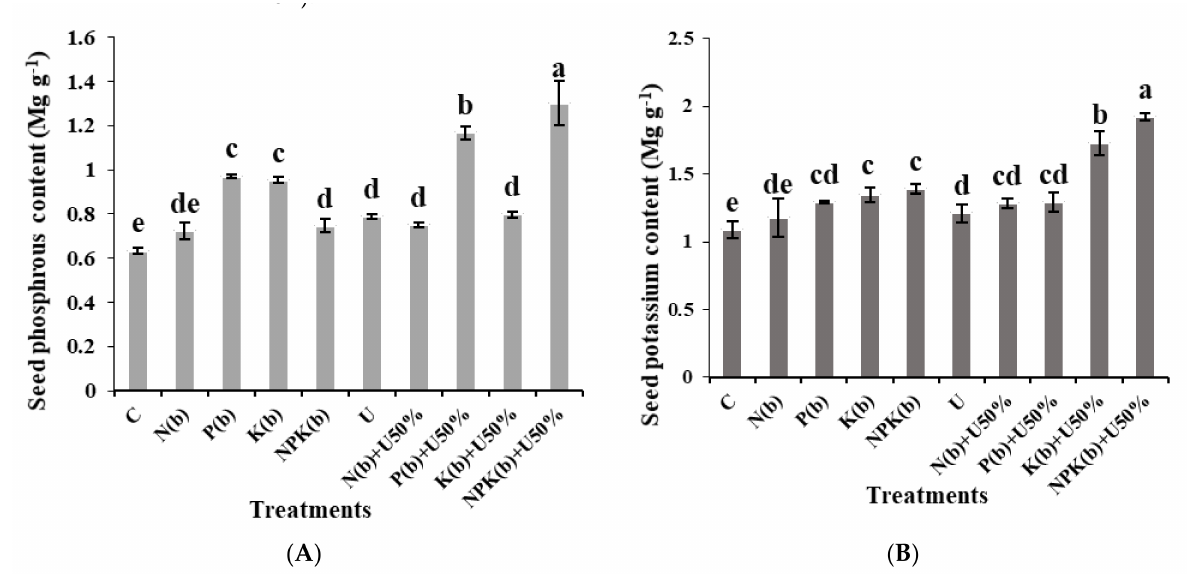
Figure 8. Means comparison for seed phosphorous content ( A ) and seed potassium content ( B ) of Nigella sativa L. as influenced by biofertilizers and chemical urea. Different letters indicate a significant difference according to PLSD test with 3 replications at the p ≤ 0.05 (chemical urea fertilizer (U), biofertilizer N (b) , biofertilizer P (b) , biofertilizer K (b) , mixed biofertilizer NPK (b) , 50% urea + biofertilizer N (N (b) + U 50% ), 50% urea + biofertilizer P (P (b) + U 50% ), 50% urea + biofertilizer K (K (b) + U 50% ), and 50% urea + biofertilizer NPK (NPK (b) + U 50%